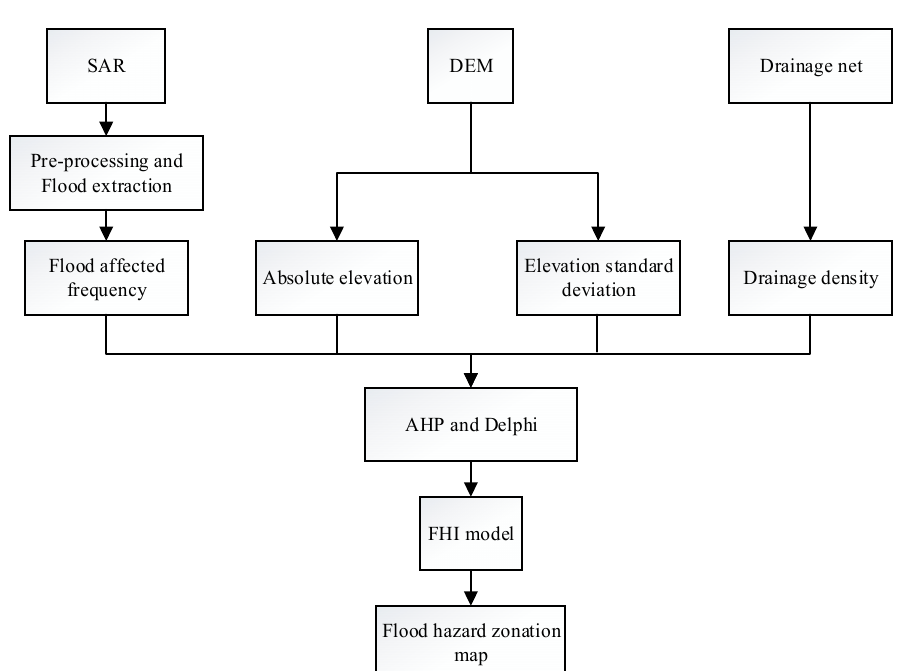
Figure 2. Flow chart of flood hazard assessment at Angkor.